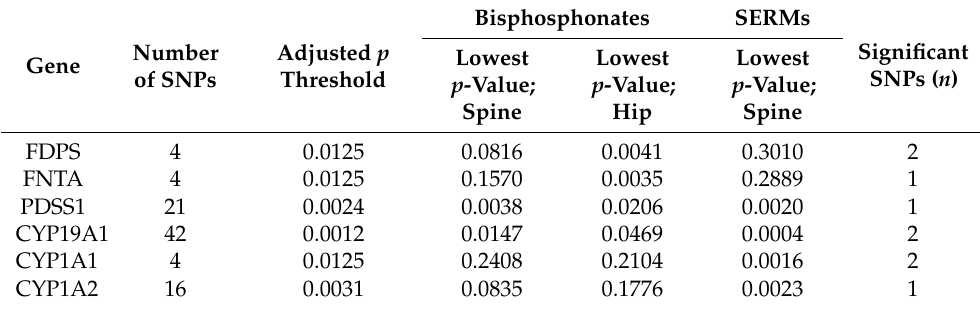
treated patients in the oestrogen ‐ related genes.